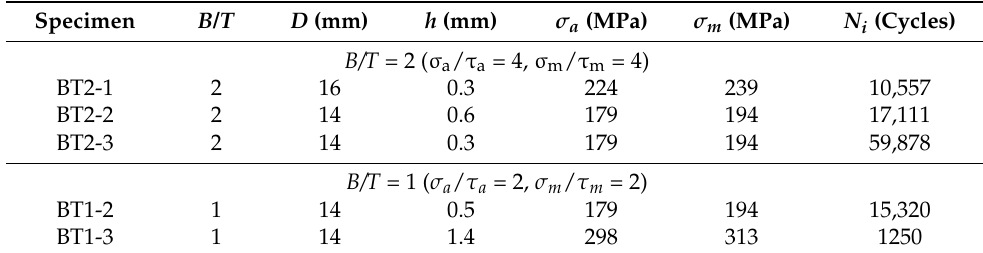
Figure 1. Specimen geometry used in the bending–torsion fatigue tests [44]. Table 3. Summary of the multiaxial fatigue test program